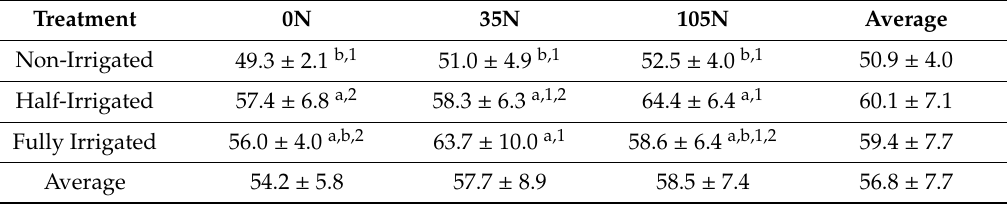
Table 12. The e ff ect of di ff erent fertilization rates on flower number per plant of soybean (cv. Pannonia Kincse) under di ff erent irrigation regimes, averaged among 2017, 2018, and 2019 in Debrecen, Hungary.